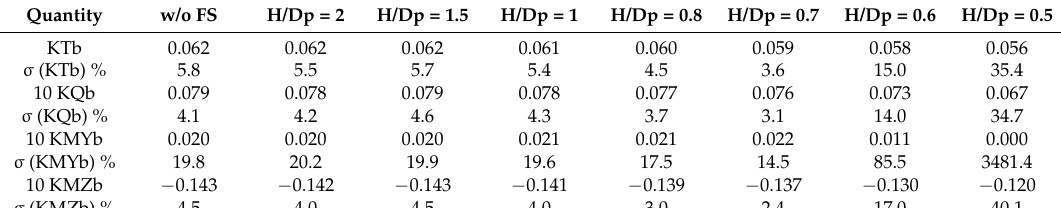
Table 6. Computed single blade loads at J=0.6 for different magnitudes of propulsor submergence.